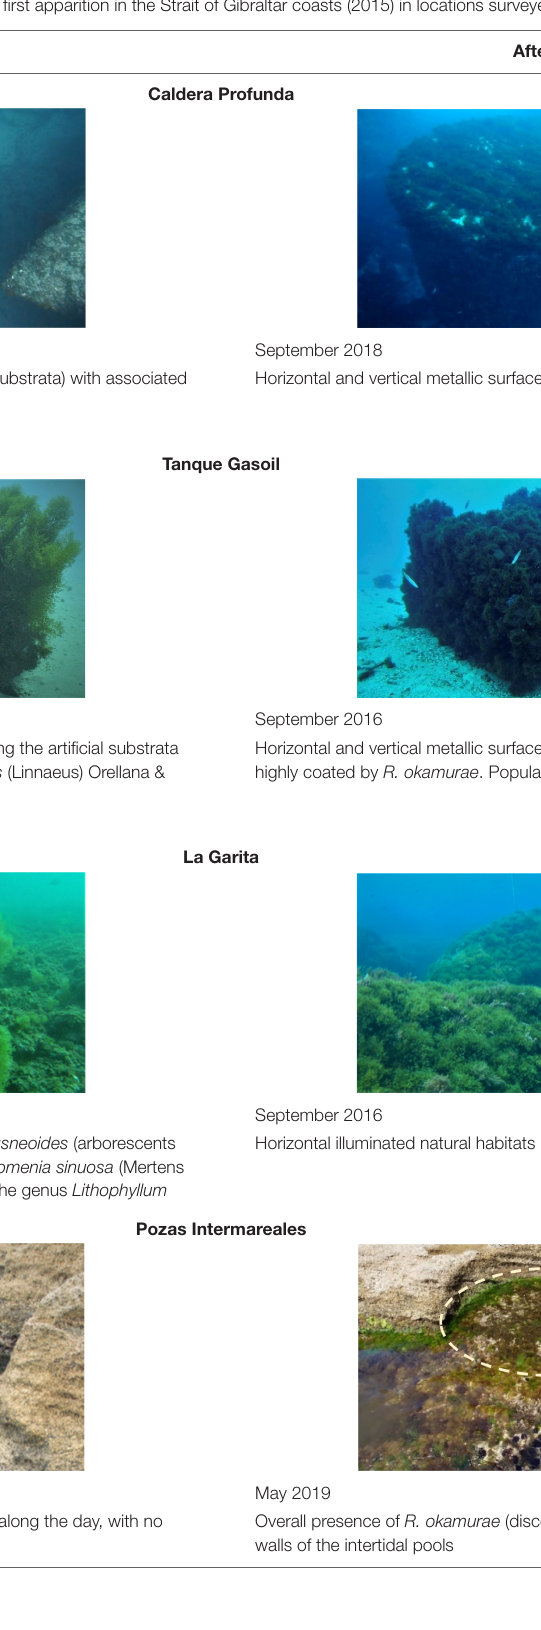
TABLE 2 | Comparisons before and after R. okamurae first apparition in the Strait of Gibraltar coasts (2015) in locations surveyed in the study